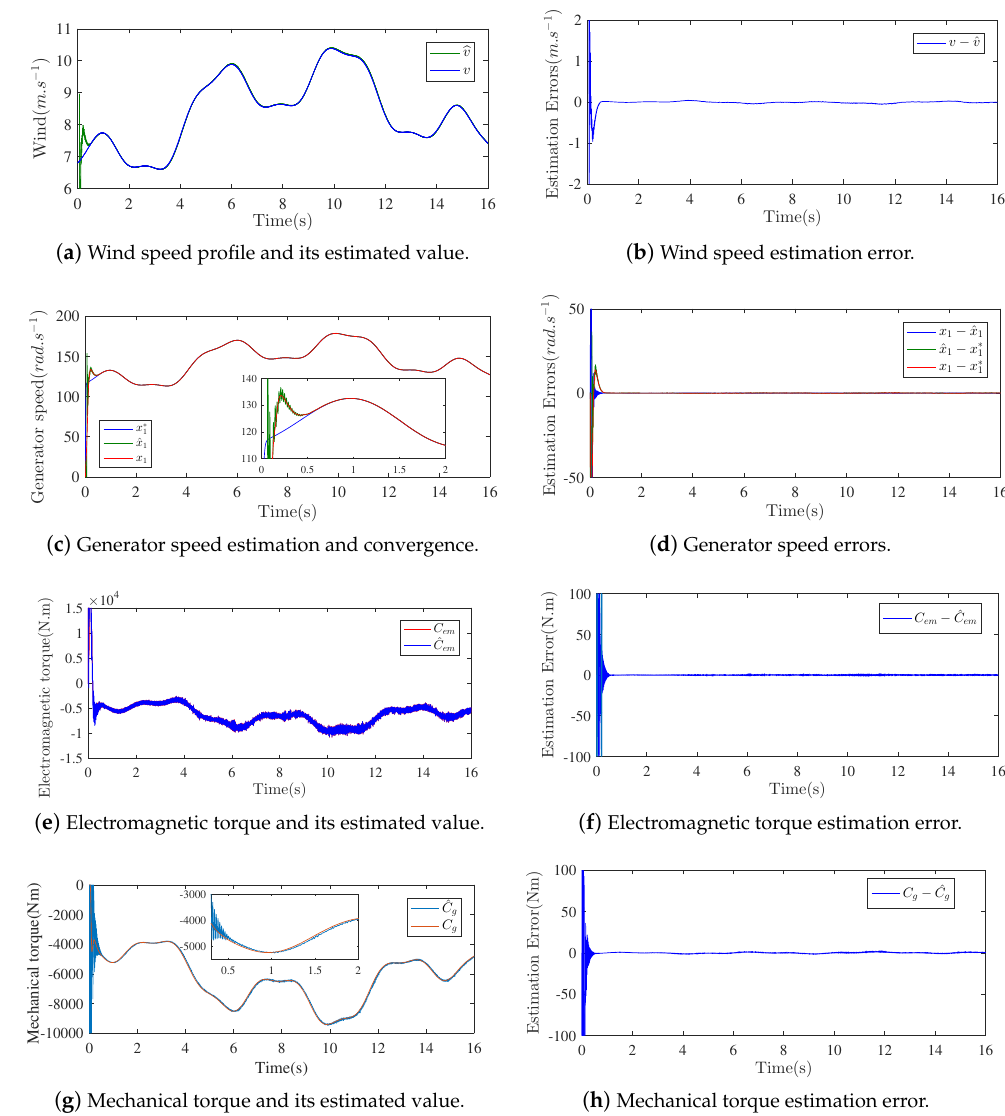
Figure 10. Output feedback control-based sensorless MPPT